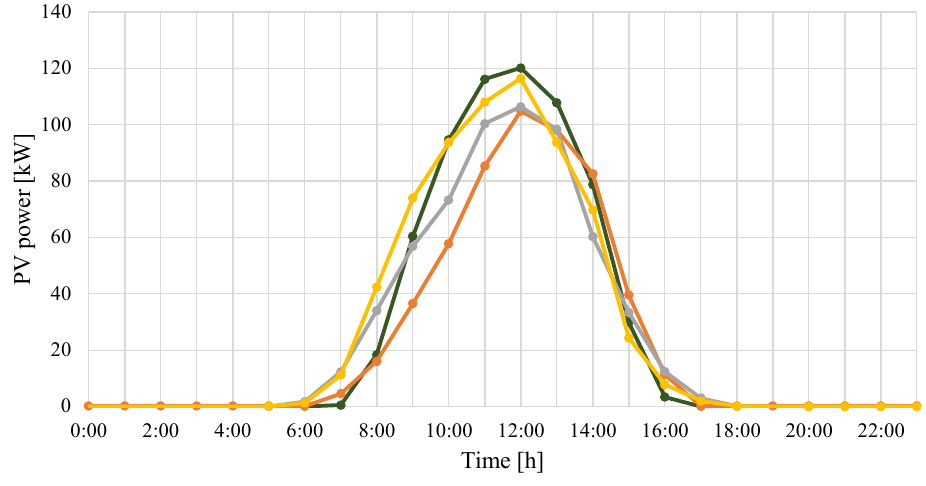
Figure 6. Day-ahead prediction of the PV power output of a random date in the test set for models based on the transfer learning.